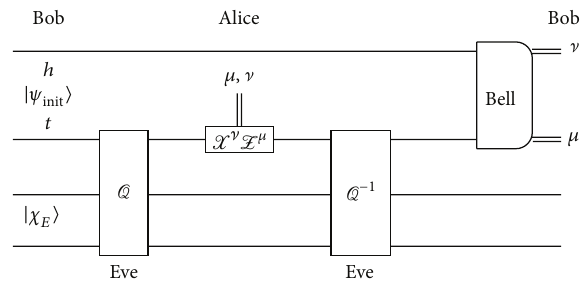
Figure 3: A schematic diagram of an individual attack.